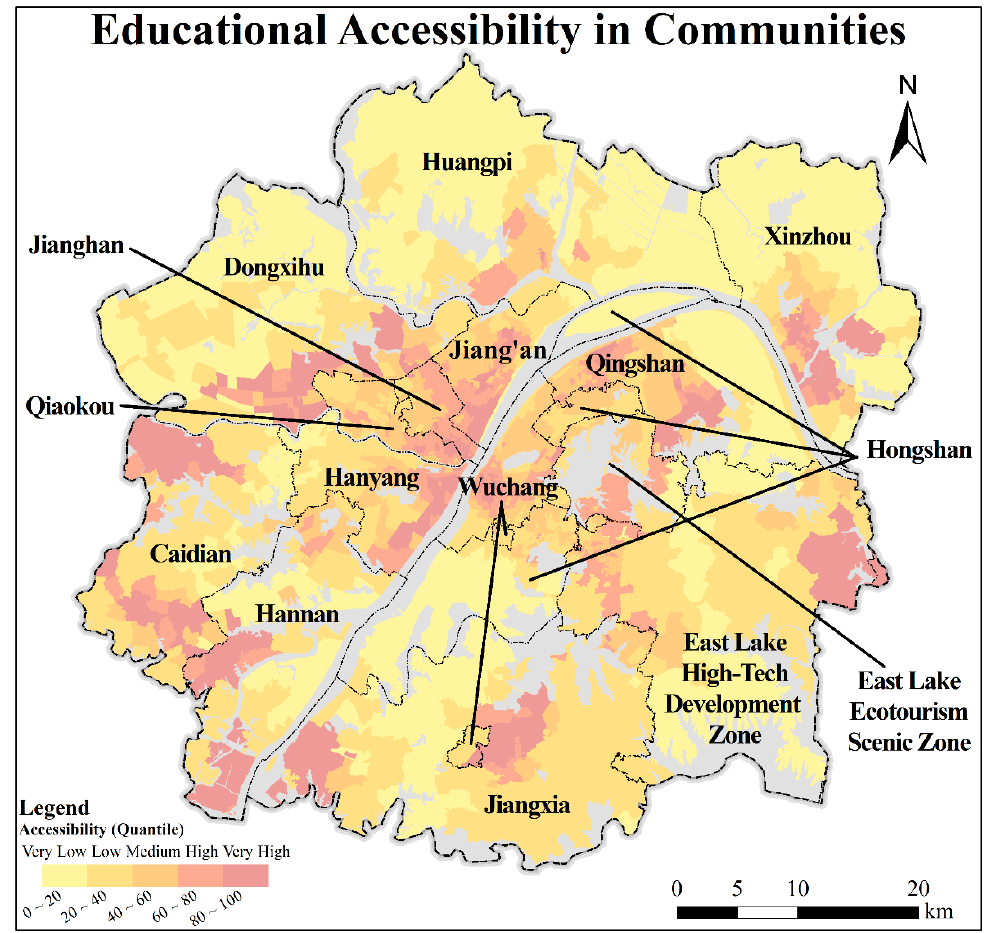
Figure 5. Educational accessibility in communities based on the MMH2SFCA method.